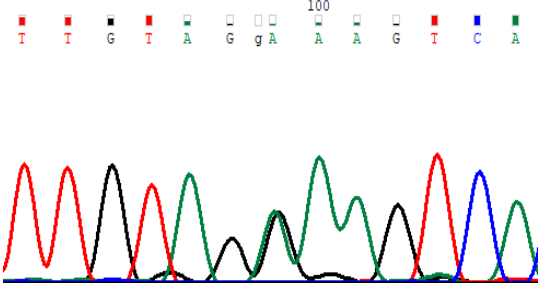
Figure 8. Chromatogram of 4 exon fragment sequences (c.274G > A).